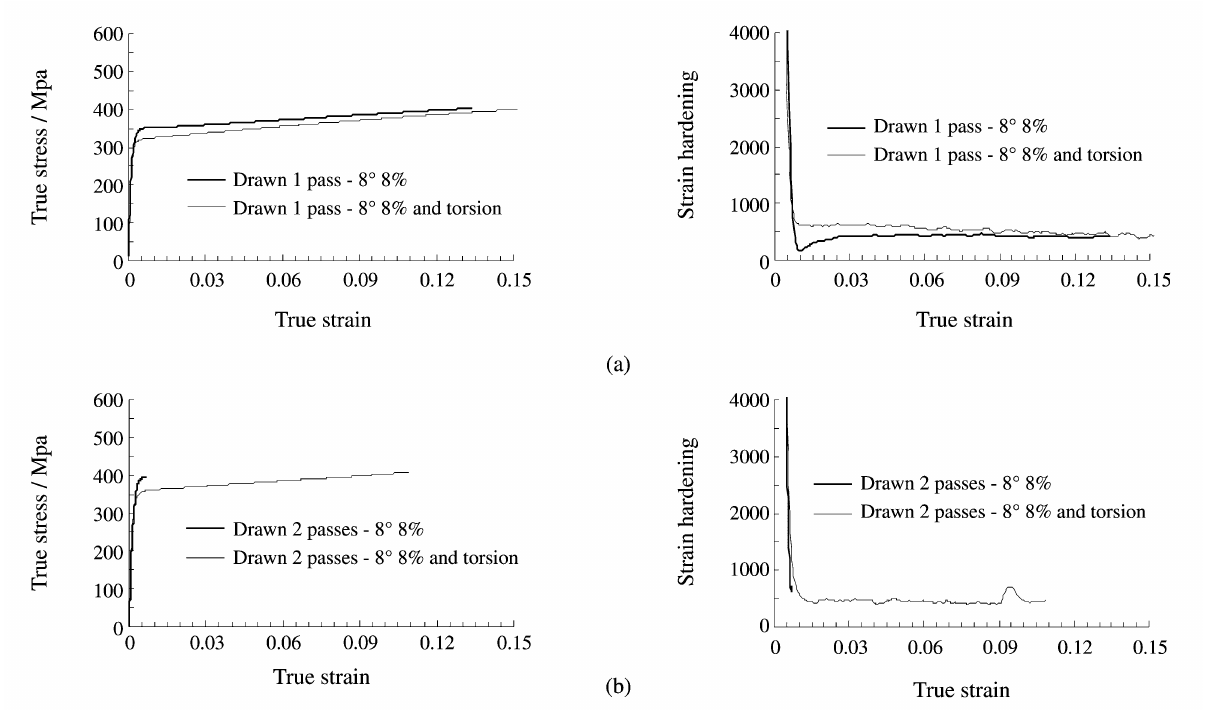
Figure 2. Effect of cyclic torsion on the hardening behavior of drawn (semi-angle 8° and reduction in area of 8%) samples: (a) 1 pass and (b) 2 passes.